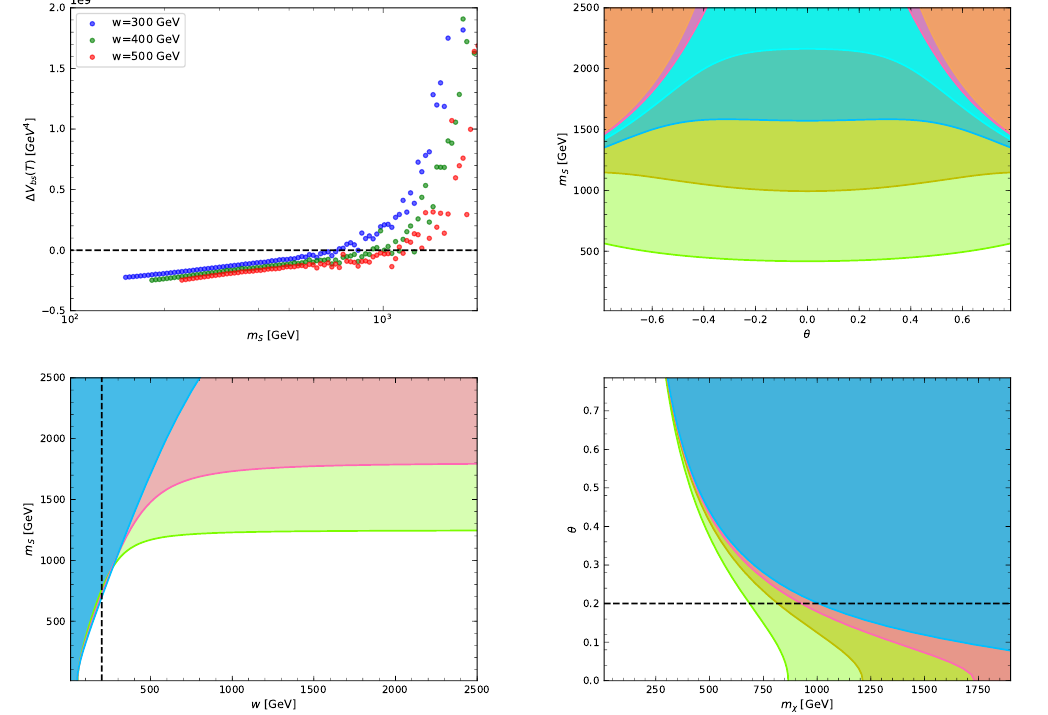
Figure 3 . Upper left plot: (cid:1) V bs ( T ) as a function of m S , with (cid:18) = 0 : 4, m (cid:31) = 300 GeV, and T = 300 GeV. The blue, green, and red points represent respectively the results with w = 300 GeV, 400 GeV, and 500 GeV. Upper right plot: unitarity bounds in the (cid:18) - m S plane, with m (cid:31) = 300 GeV. Colored regions in this (cid:12)gure are excluded by various constraints. The values of w in this plot are 100 GeV (green), 200 GeV (yellow), 300 GeV (deep blue), 400 GeV (light blue), 600 GeV (pink), and 1000 GeV (sandy-brown) respectively. Lower left plot: unitarity bounds in the w - m S plane, with (cid:18) = 0 : 2 (blue), 0.4 (pink), and 0.6 (green), respectively. Lower right plot: condition (2.13) in the m (cid:31) - (cid:18) plane, with w = 1000 GeV. The green, yellow, pink, and blue regions represent the bounds with m S = 500 GeV, 700 GeV, 1000 GeV, and 1500 GeV,